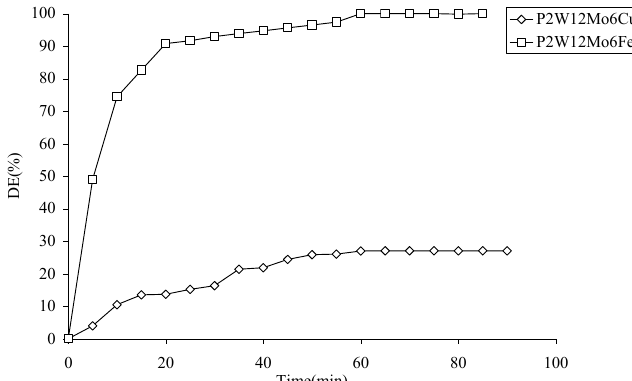
Figure 8: Comparison of oxidation of NBB using Dawson- type iron -substituted heteropolyanion and Dawson- type copper -substituted heteropolyanion as catalysts Experimental condition: [pH=3, [catalyst mass=0.005g, [H 2 O 2 ]=0.01mM.